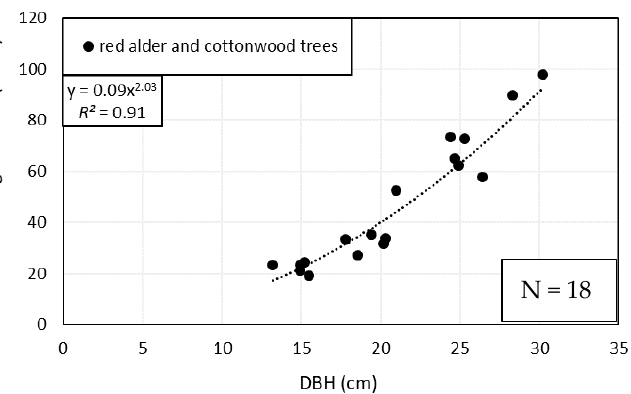
Figure 4. Relationship between F M and diameter at breast height (DBH) for red alder and cottonwood trees.